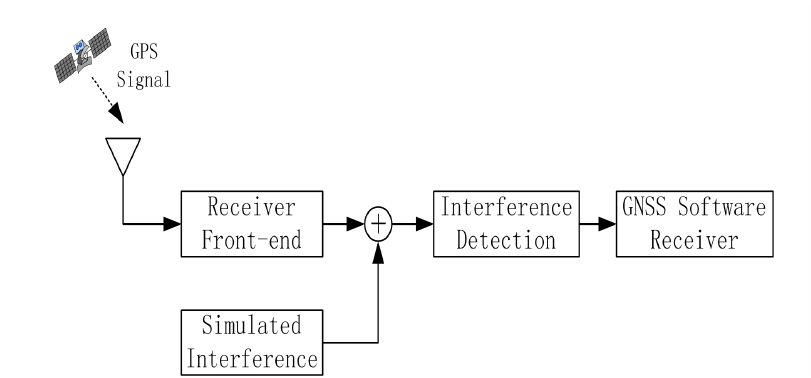
Figure 5. Scheme of the measurement test in the lab.